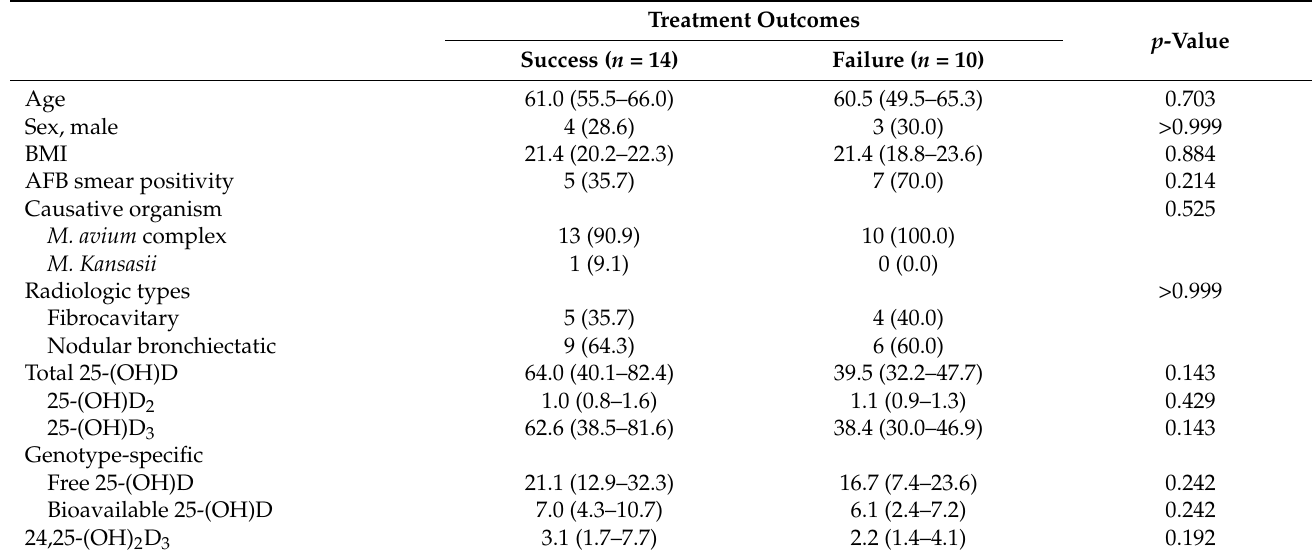
Table 5. Vitamin D parameters in patients with NTM-PD according to the treatment